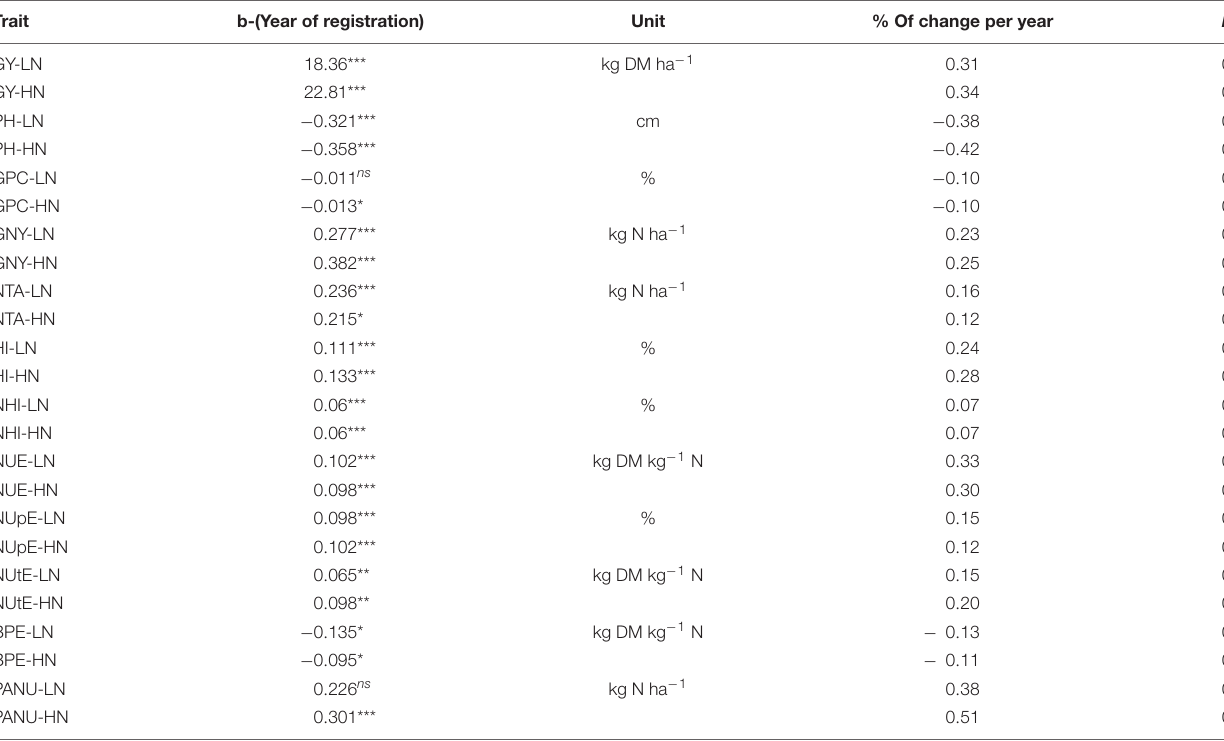
TABLE 5 | Linear regression between year of cultivar registration (1936–2016) and analyzed traits a at LN and HN levels (N of cultivars = 48).